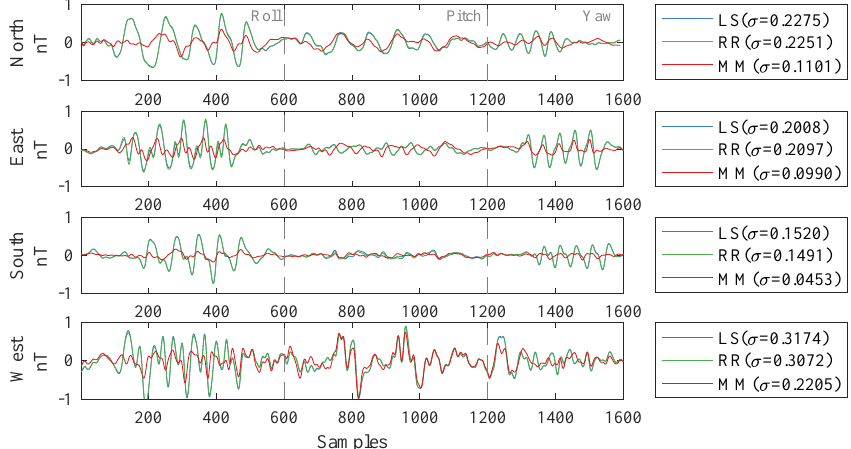
Figure 6. Compensation results of the three compensation methods. In the legends, σ represents the standard deviation (STD), with unit of